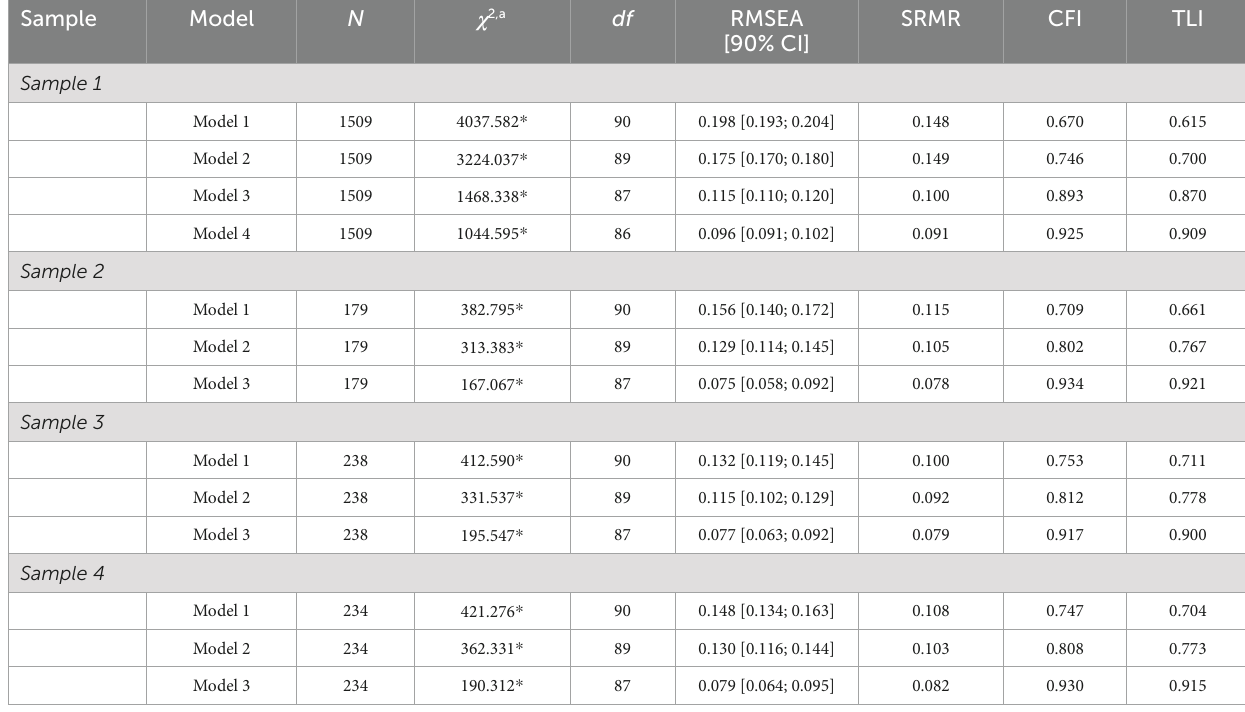
TABLE 1 Comparison of fit indices from confirmatory factor analyses of different Work-Related Rumination Questionnaire (WRRQ) factor models across studies. Sample Model Sample